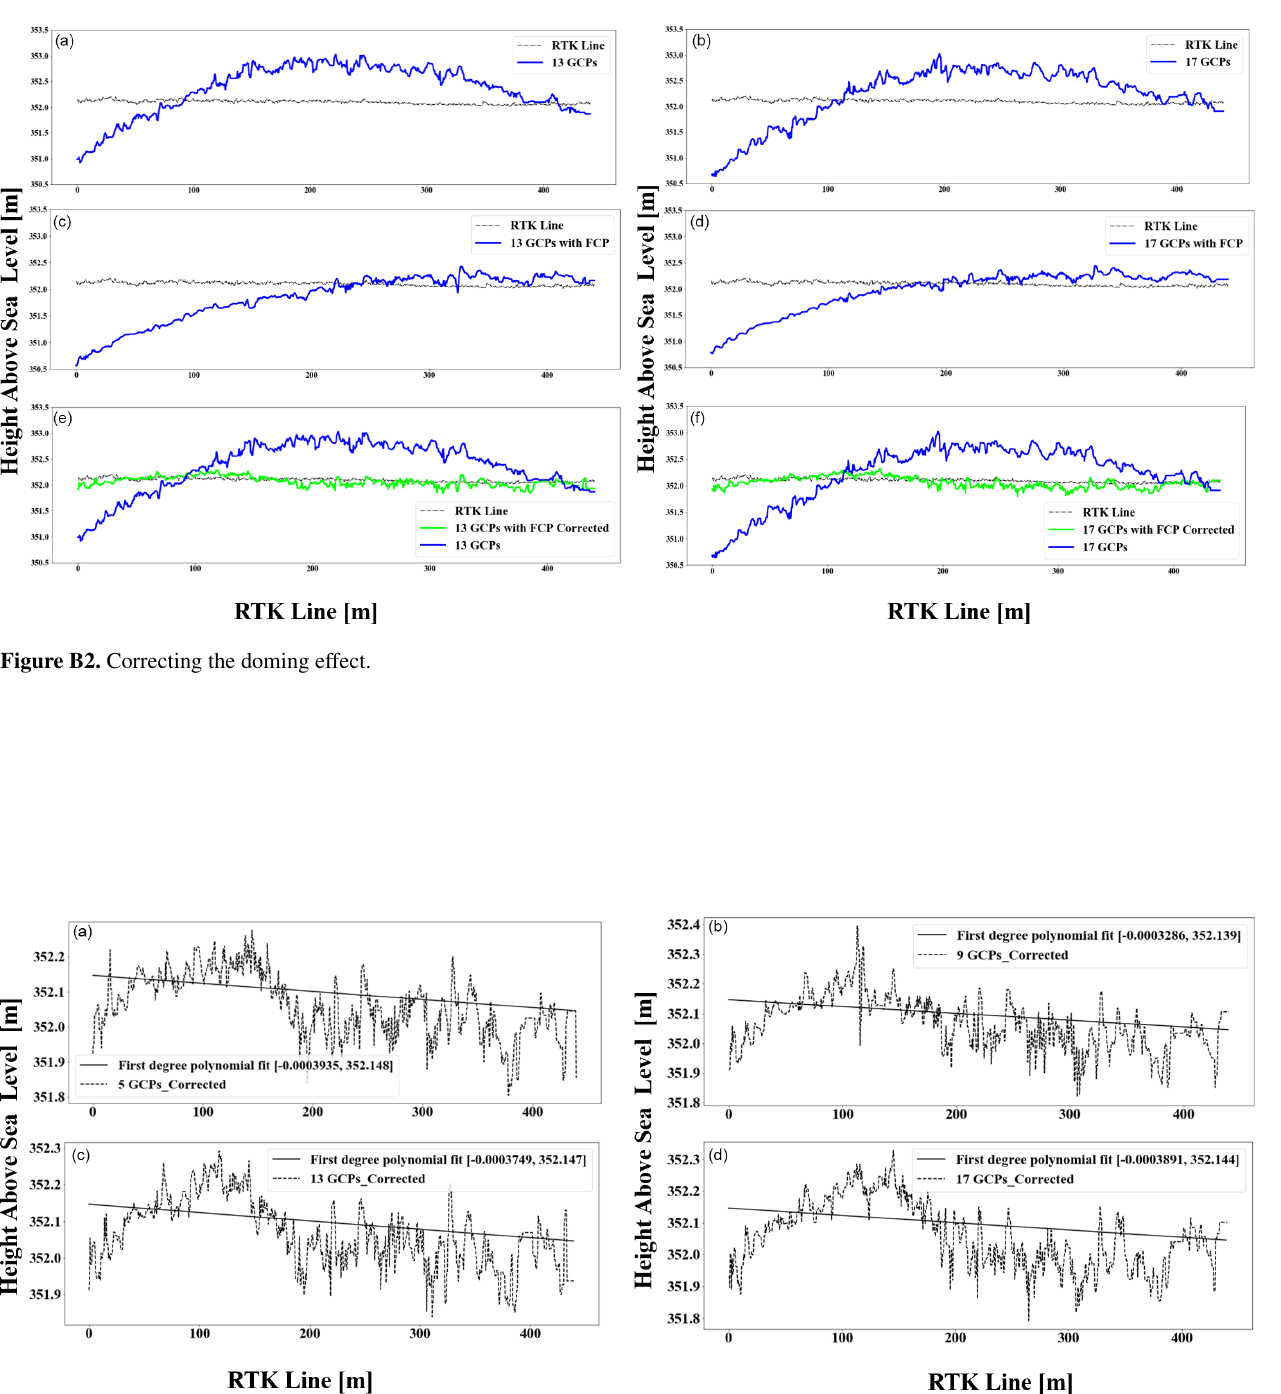
Figure B3. First-order polynomials through extracted